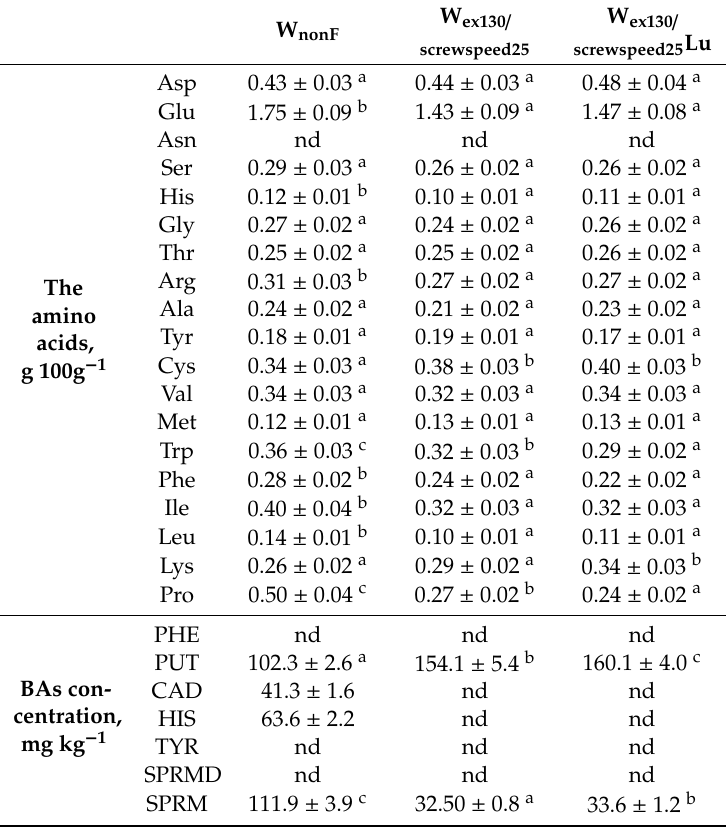
Table 4. The amino acids (g 100 g − 1 ) and biogenic amines (mg kg − 1 ) concentration in extruded and nontreated cereal by-products non-fermented and fermented with L. uvarum